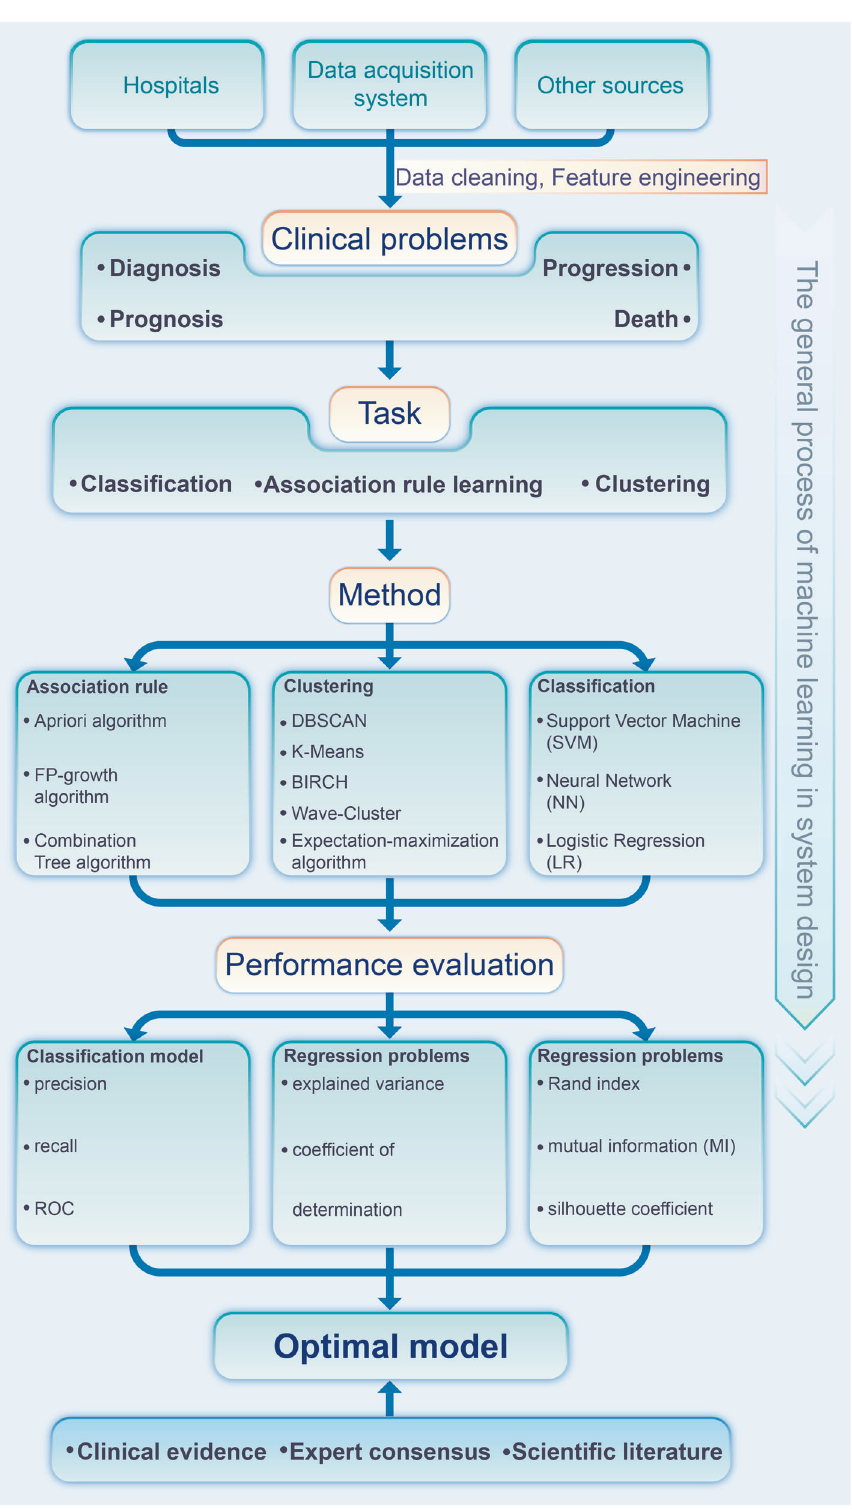
Fig. 5 Flow chart of the system design detection rate of nucleic acid decreased, and the detection rate of antibody increased. The combined detection of nucleic acid and antibody can reduce the rate of missed diagnosis. When using antibody detection alone, the interpretation of the results should be cautious, speci fi cally, we need to check the Signal Transduction and Targeted Therapy (2021)